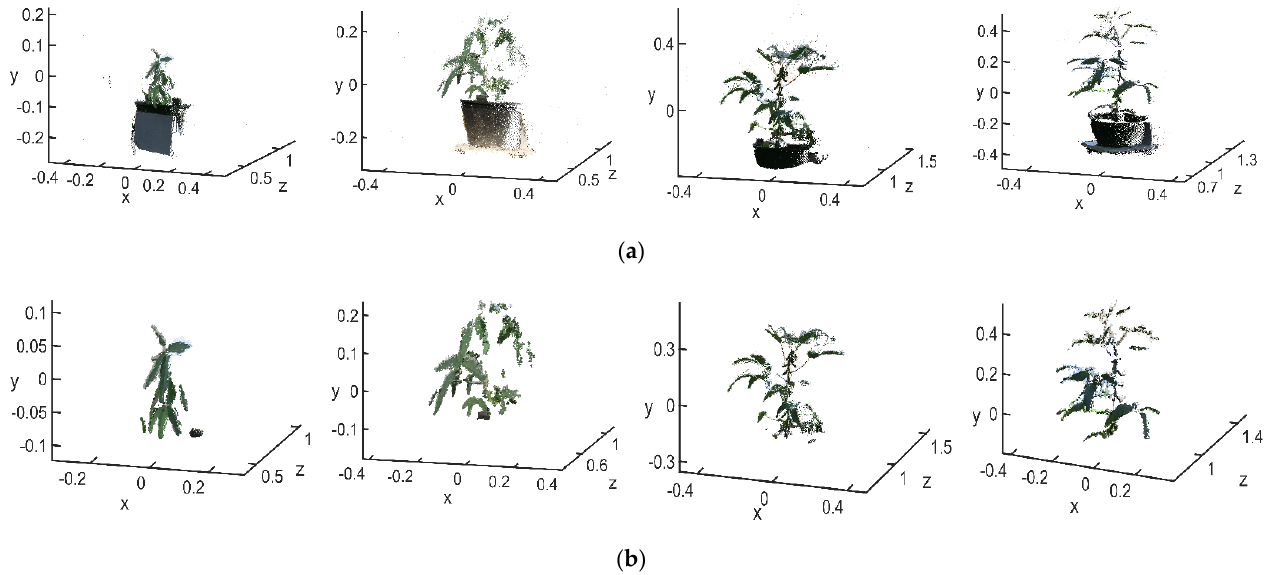
Figure 5. Point cloud after noise reduction: ( a ) before k-nearest neighbor filtering; ( b ) after k-nearest neighbor filtering.